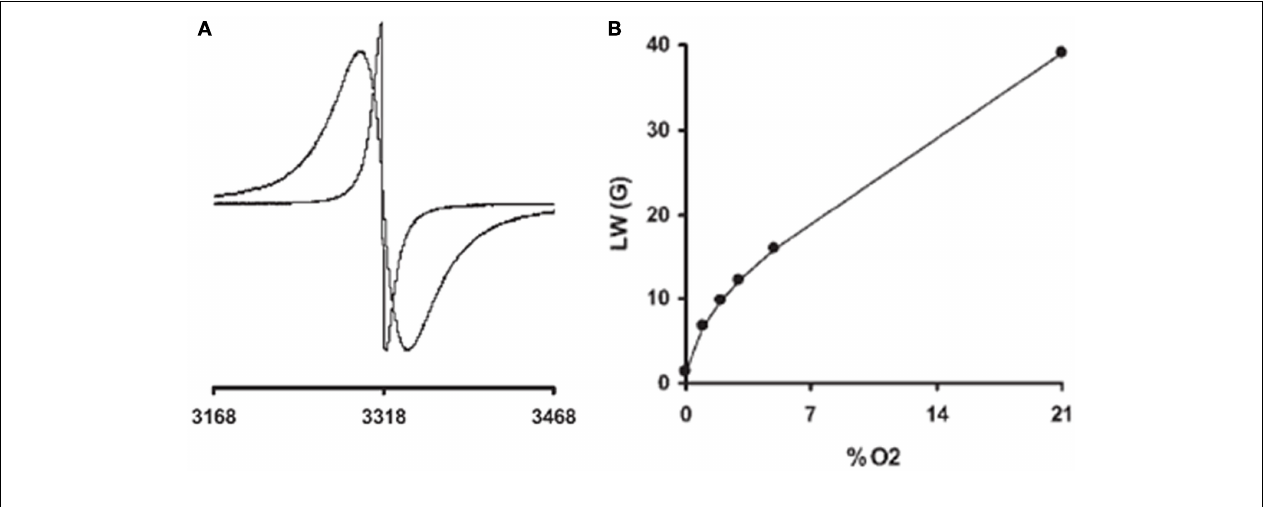
Typical calibration curve (linewidth as a function of the pO 2 ) of a charcoal (oxygen sensor probe) possessing a curvilinear response, with a higher sensitivity to oxygen at low pO 2 . Adapted from Gallez et al.